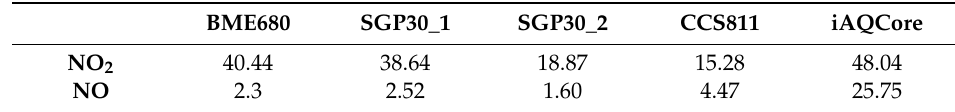
Table 4. Estimated LOD ( µ g / m 3